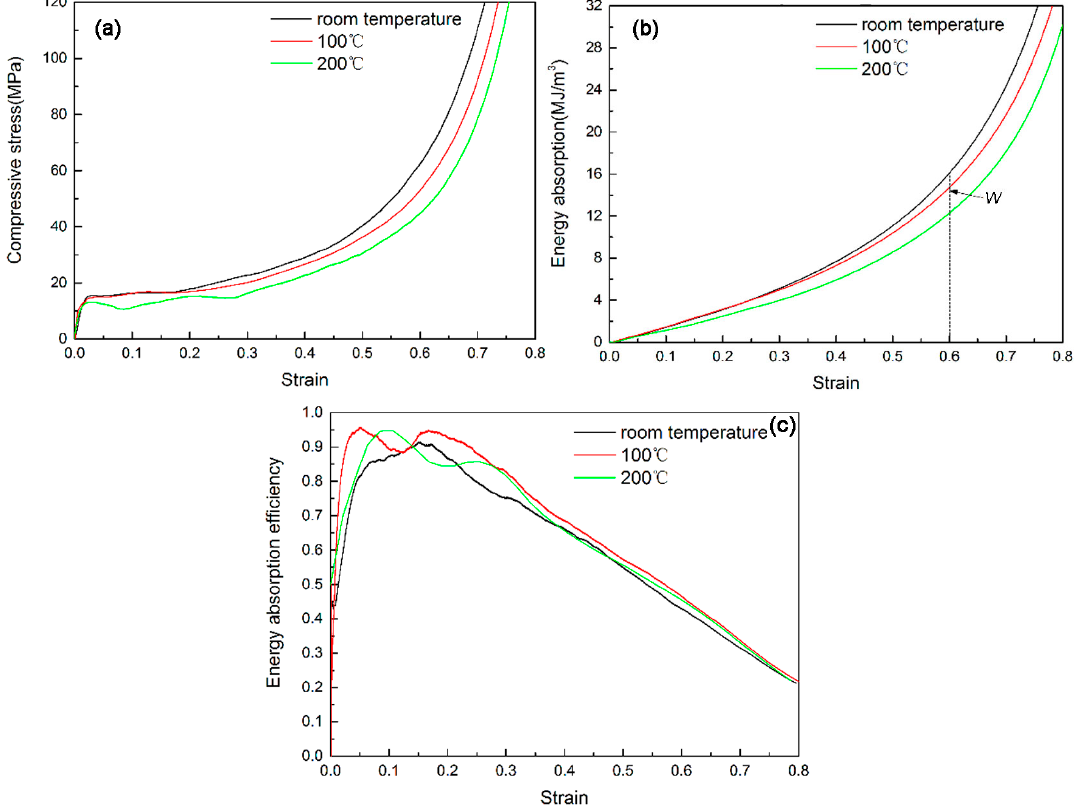
Figure 9. The compressive properties of the hybrid foams at different temperatures: ( a ) compressive curves; ( b ) energy absorption and; ( c ) energy absorption efficiency.